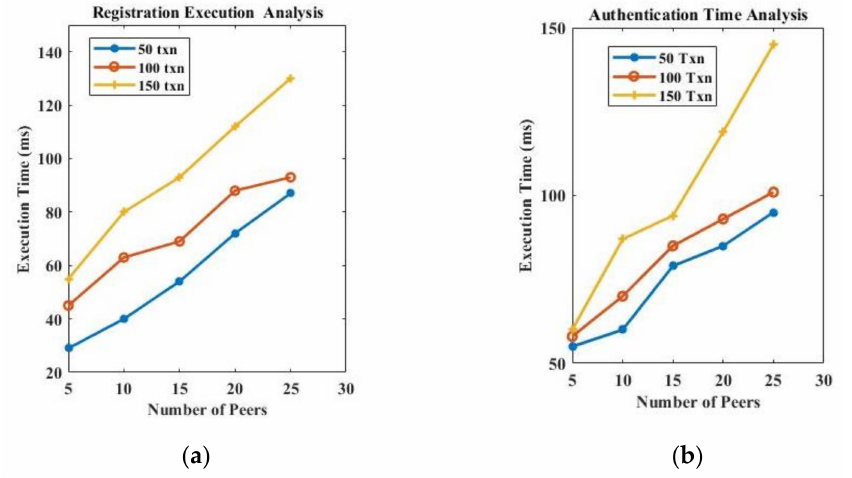
Figure 7. ( a ) Registration time on network scale; ( b ) authentication time on network